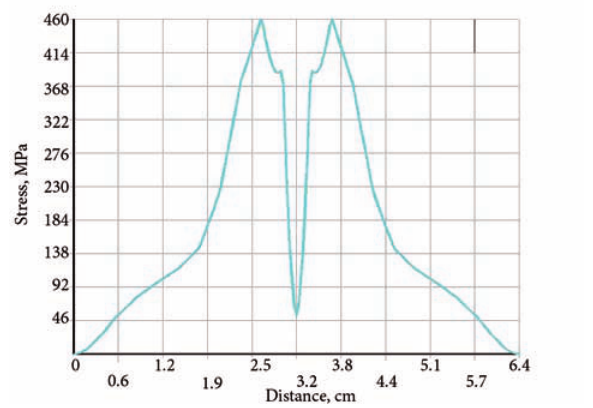
Fig. 19. Von Misses stress field distribution on control line points as joint is cooling down to room temperature,